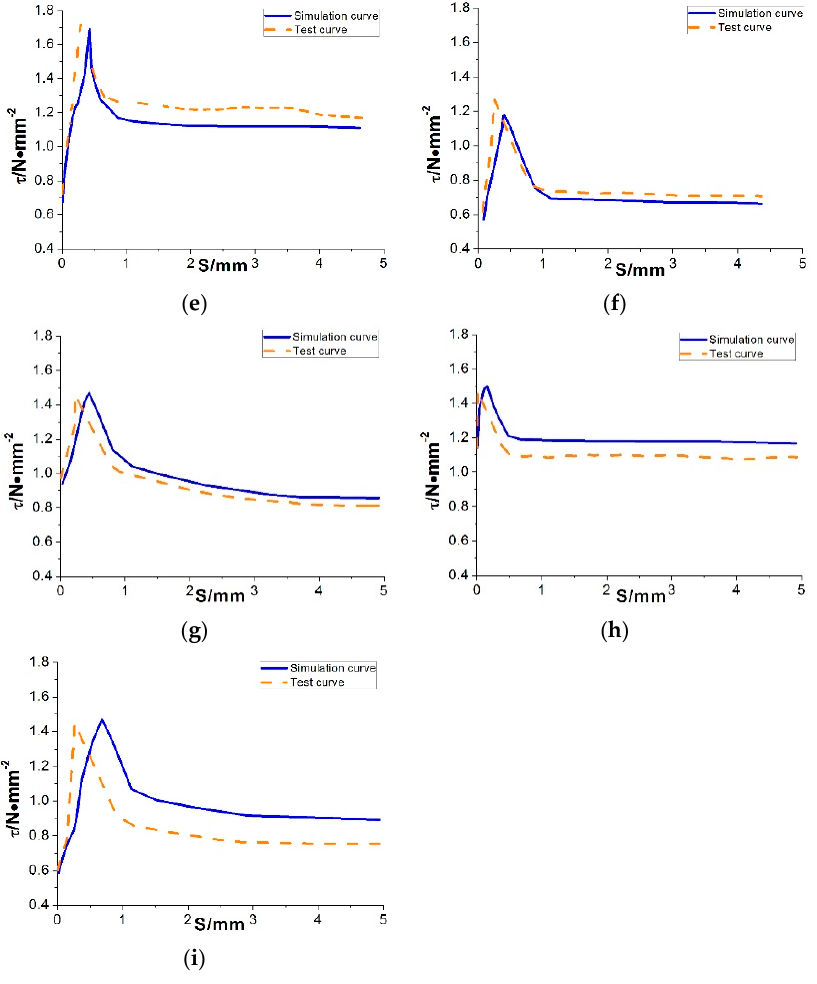
Figure 17. Simulation and test curves of τ -s: ( a ) SRRC-1; ( b ) SRRC-2; ( c ) SRRC-3; ( d ) SRRC-4; ( e ) SRRC-5; ( f ) SRRC-6; ( g ) SRRC-7; ( h ) SRRC-8; ( i ) SRRC-9.